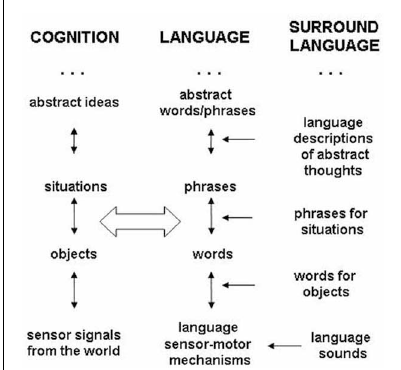
FIGURE 1 | The dual hierarchy. Language and cognition are organized into approximate dual hierarchy. Learning language is grounded in the surrounding language throughout the hierarchy. Cognitive hierarchy is grounded in experience only at the very